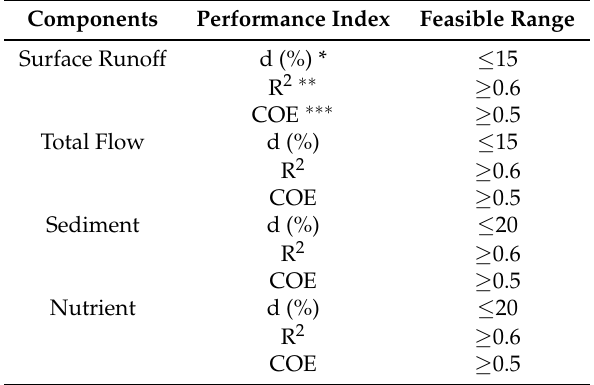
Table 3. Performance indices and the feasible range by hydrologic